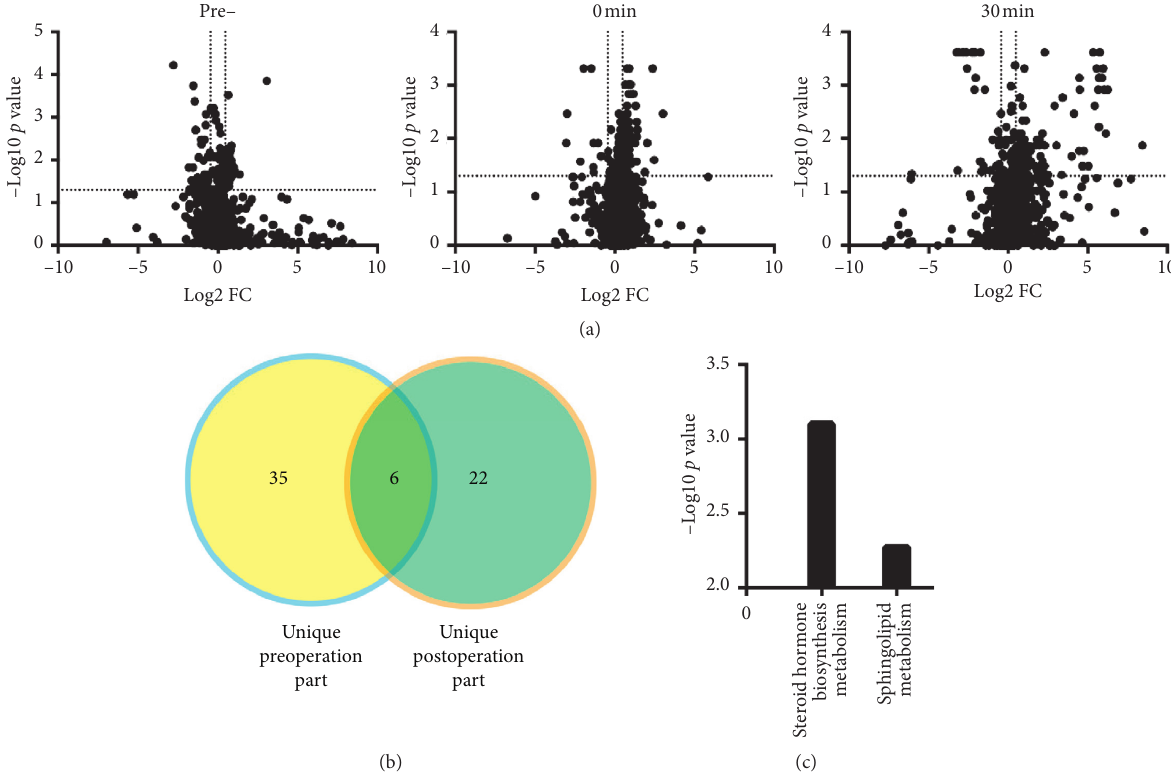
Figure 4: The specific cardiac metabolism before and after TAVR. (a) Volcano analysis regarding the difference between the ascending aorta and coronary sinus at before, immediately, and 30 minutes after implanting the transcatheter heart valve (THV); (b) the number of unique cardiac metabolite before and after THV; (c) the involved metabolism pathway before and after